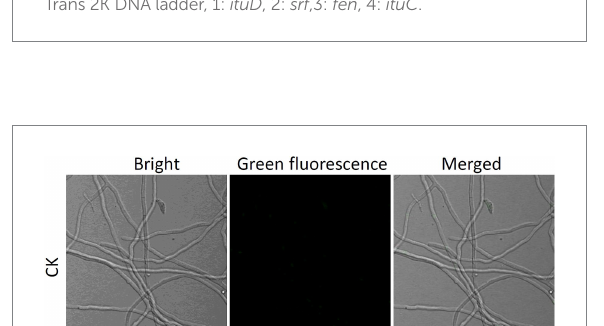
FIGURE 4 Hydrolytic enzyme activity of B. halotolerans strain Pl7. Protease (A) , cellulase (B) , and β -1, 3-glucanase (C) activity of B. halotolerans strain Pl7 was based on whether there was a transparent circle around the bacterial colony grown on skim milk medium, CMC medium and aniline blue medium, respectively. The pictures were taken at 3 dpi at 28 ° C.